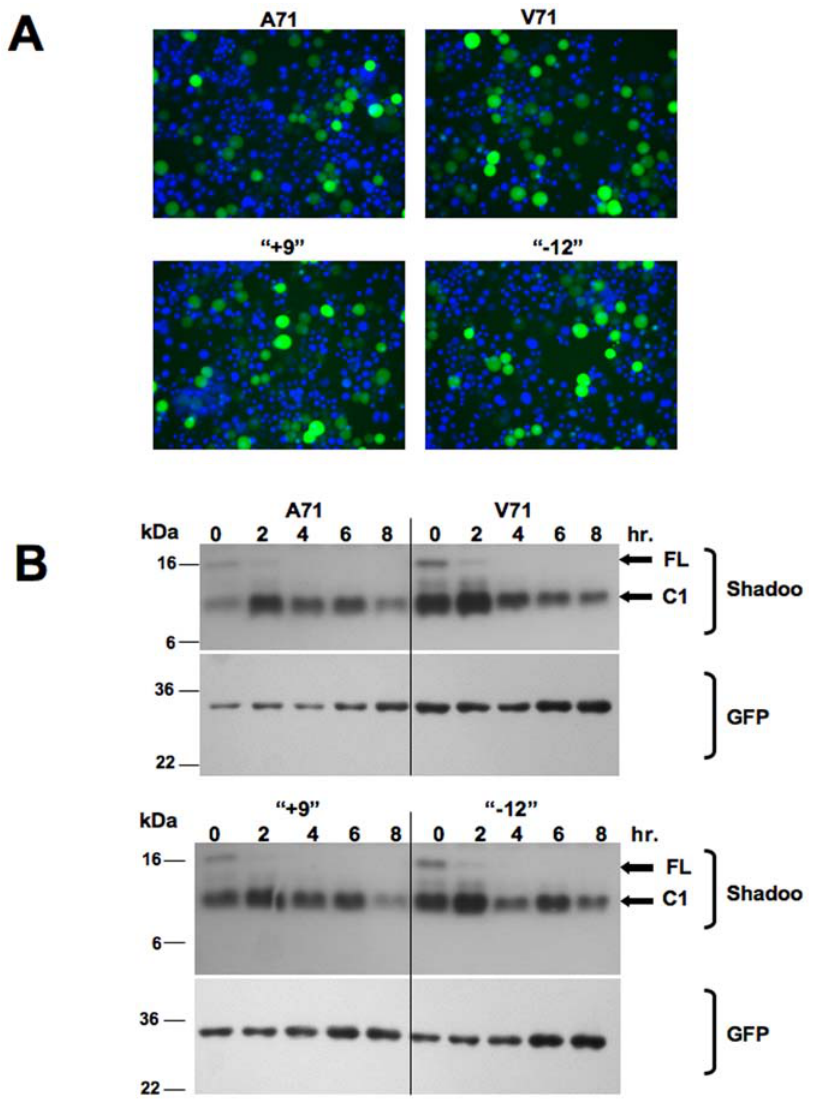
Figure 6. Expression and turnover of Sheep Sho alleles in transfected N2a cells. (A) GFP fluorescent signals in fields of transfected cells to demonstrate similar transfection efficiencies. Individual values were V71 (10.1%), A71 (5.1%), ‘‘ + 9’’ (8.7%), ‘‘ 2 12’’ (7.1%). (B) Western blot analysis of N2a transfected cells chased for different time periods in the presence of cycloheximide. Proteins samples are de-glycosylated with PNGase F. Positions of full-length and C1 fragments of sheep Sho are indicated, detected with a C-terminal anti-Sho